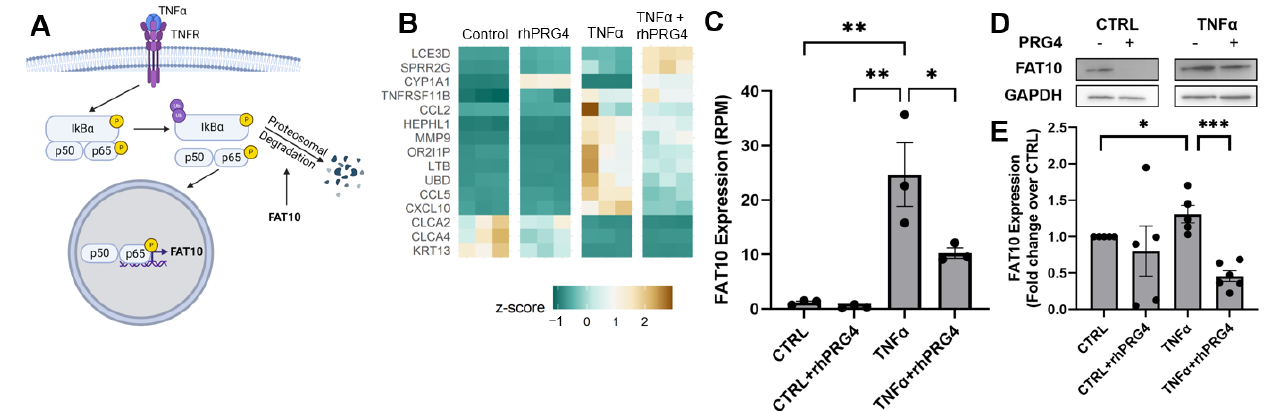
Figure 4. The effect of rhPRG4 on FAT10 expression. ( A ) FAT10’s role in NF κ B signaling. Created with BioRender.com ( B ) Heatmap showing genes that were most significantly changed by TNFα and rhPRG4. ( C ) FAT10 RNA expression in RPM from RNA sequencing (N = 3, assessed by one-way ANOVA, * p < 0.05, ** p < 0.01). ( D ) FAT10 expression on the protein level by Western Blotting. ( E ) Relative FAT10 expression normalized to GAPDH expression and to CTRL samples, analyzed using GeneTools software (N = 5–7, assessed by two-way t-tests with Bonferroni correction, * p < 0.05, *** p <